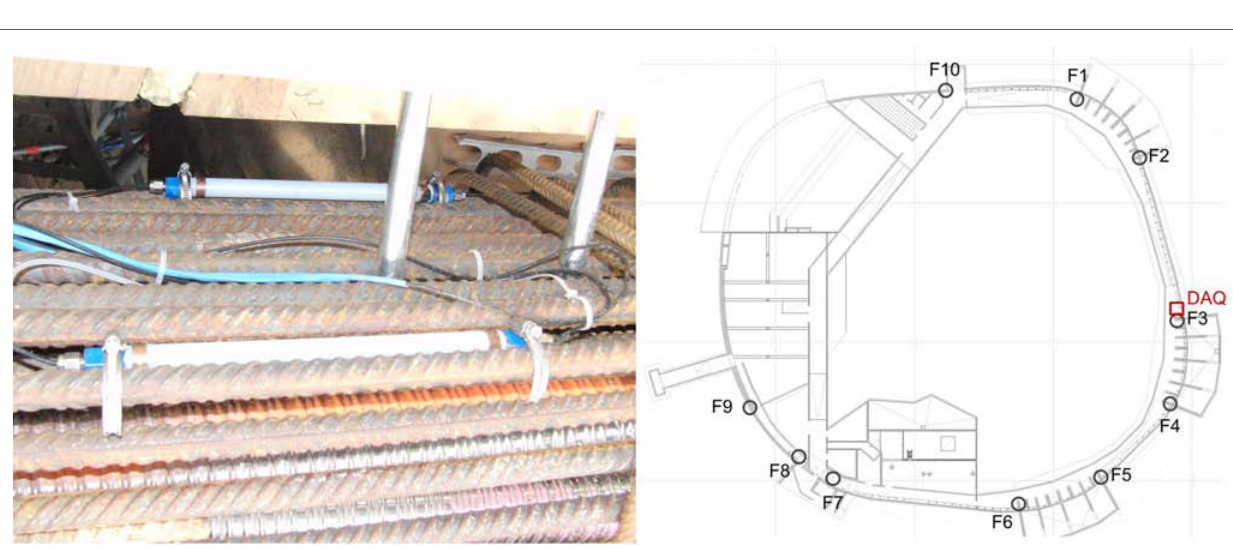
FIGURE 4 | Left: permanent deployment of the Micronoptics embeddable FBG strain sensor os3600 on a reinforcement bar; right: technical drawing indicating the position of sensors and the DAQ